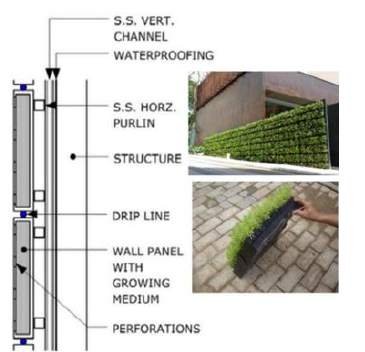
Figure 12 Modular Living Wall Detailed Drawing (URL